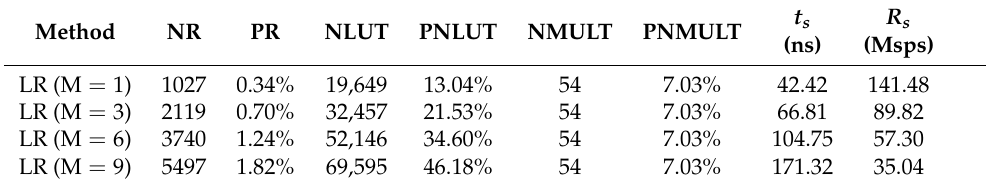
Table 4. Synthesis results regarding the hardware area occupation, processing time, and throughput for the linear regression (LR) prediction technique, NI = 6, and varying M from 1 to